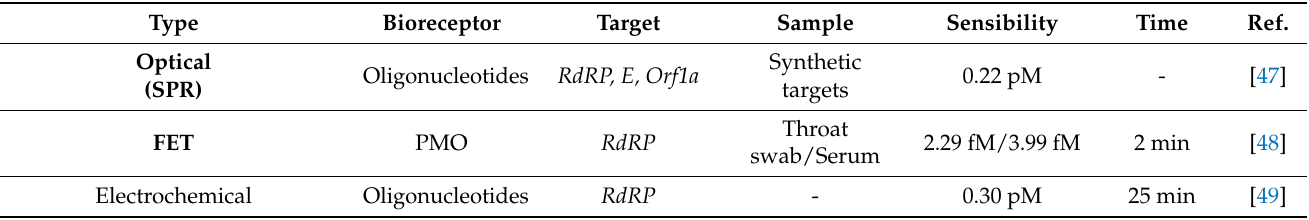
Table 1. Potentially useful biosensing methods targeting SARS-CoV-2 nucleic acid